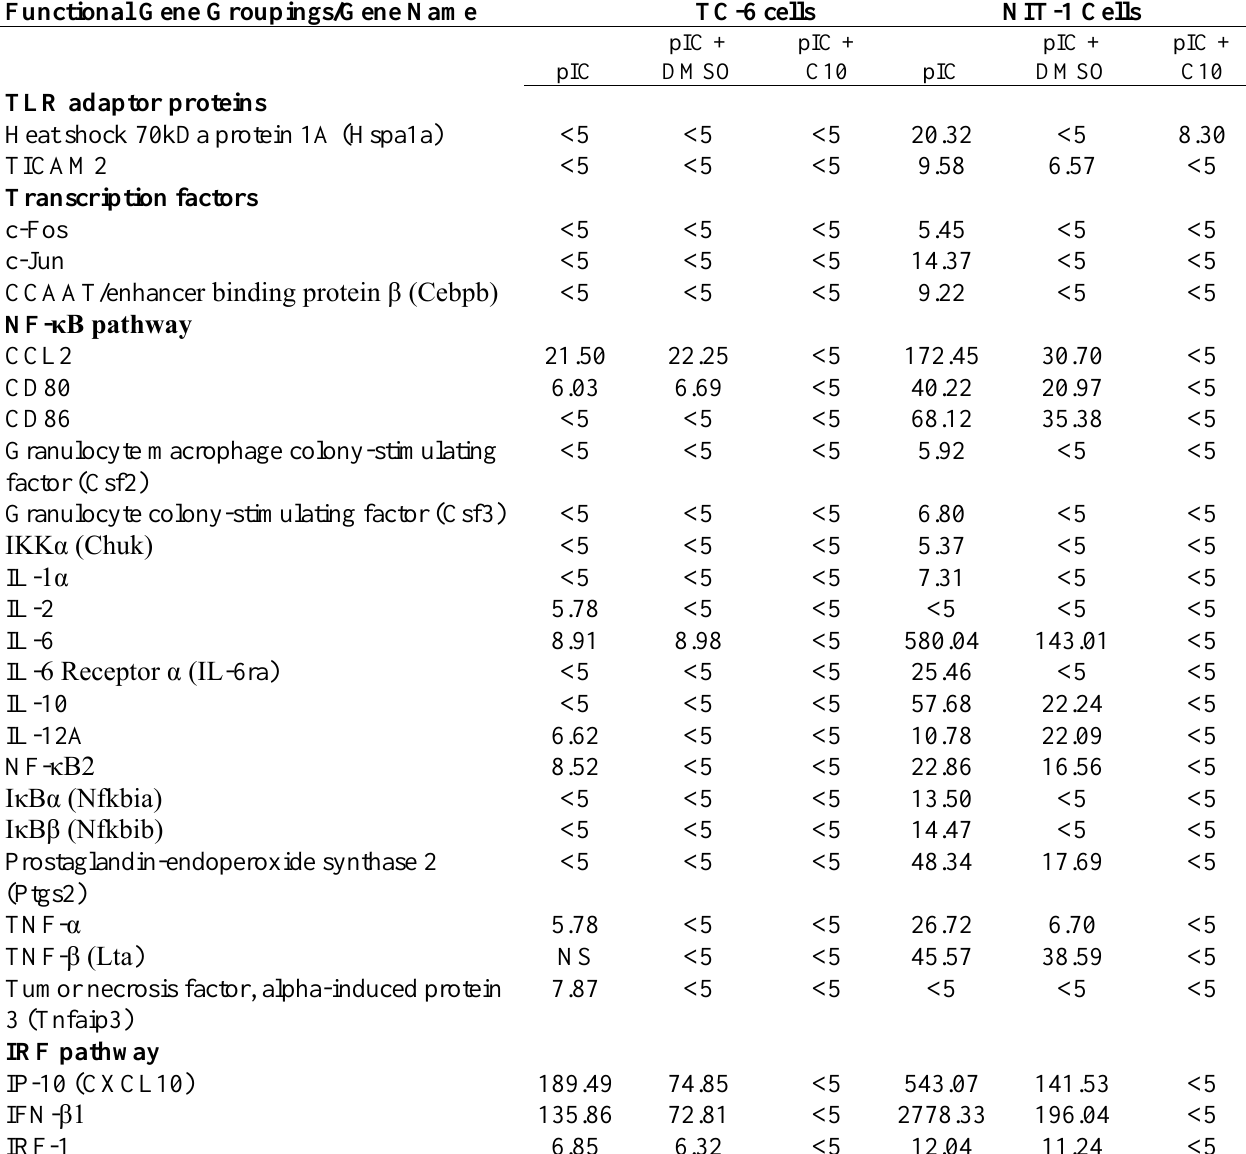
Table 2. Relative fold changes induced by pIC and inhibition by C10 on expression of genes in a TLR signaling